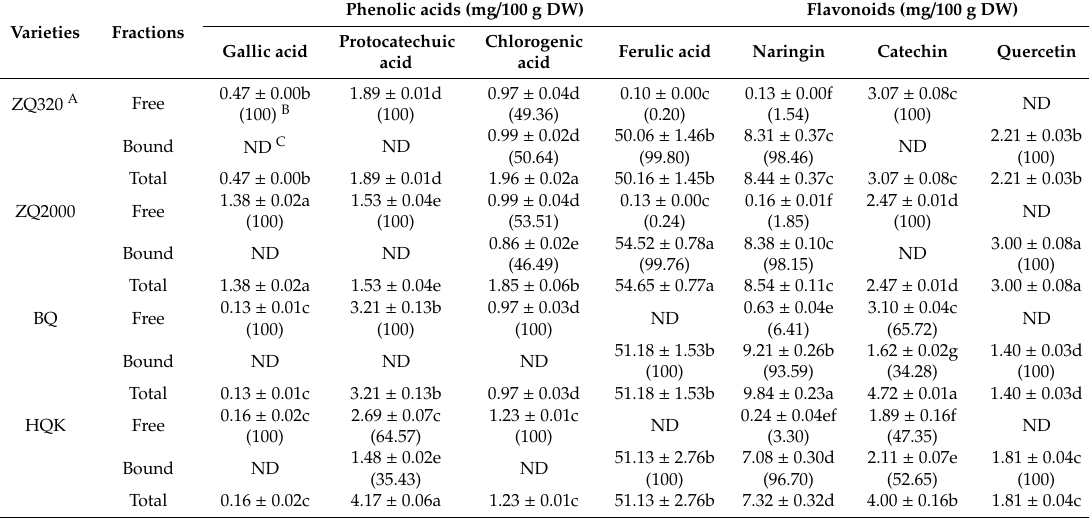
Table 2. Phenolic profiles of four highland barley varieties (mg phenolics / 100 g grain, dry weight (DW); mean ± SD, n = 3). Phenolic acids (mg / 100 g DW) Flavonoids (mg / 100 g DW) Fractions Protocatechuic Chlorogenic Gallic acid acid